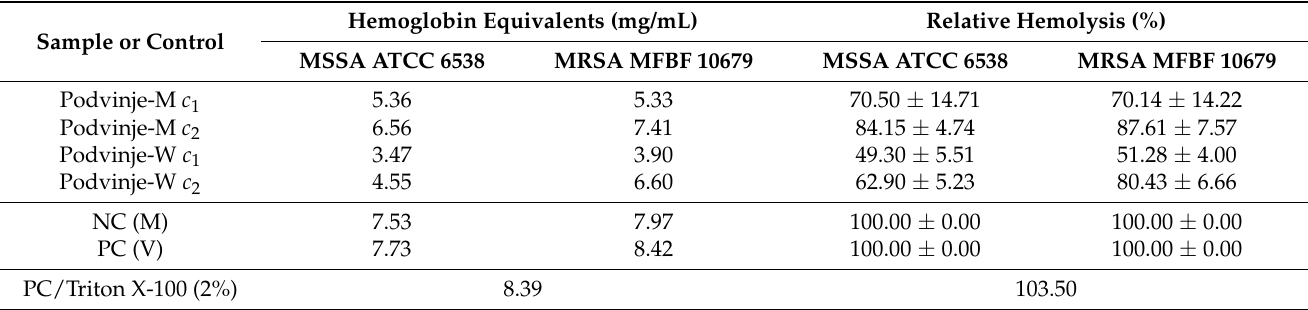
Table 4. Anti-hemolytic activity of E. cicutarium water (Podvinje-W) and methanolic (Podvinje-M) extracts from the Podvinje locality on MSSA and MRSA strains, expressed as relative hemolysis (%) and bovine hemoglobin equivalents (A 540 = 0.0773c + 0.0393; A 540 —absorbance at 540 nm; c—bovine hemoglobin concentration in mg/mL; R 2 =